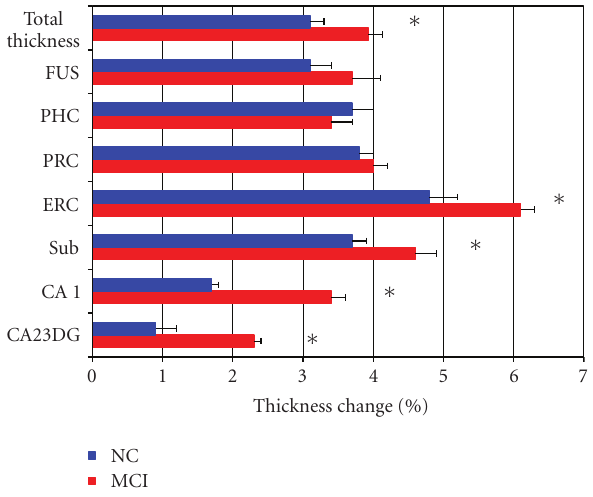
Figure 3: Cortical thickness change over time (%) across subre- gions. MCI subjects ( N = 20) compared to normal control ( N = 19) showed significantly greater cortical thinning in CA23DG, CA1, Sub, and ERC and Total Thickness (CA23DG: CA fields 2, 3 and the dentate gyrus, CA1: CA field 1, Sub: Subiculum, ERC: entorhinal cortex, PRC: perirhinal cortex, PHC: parahippocampal cortex, Fus: Fusiform